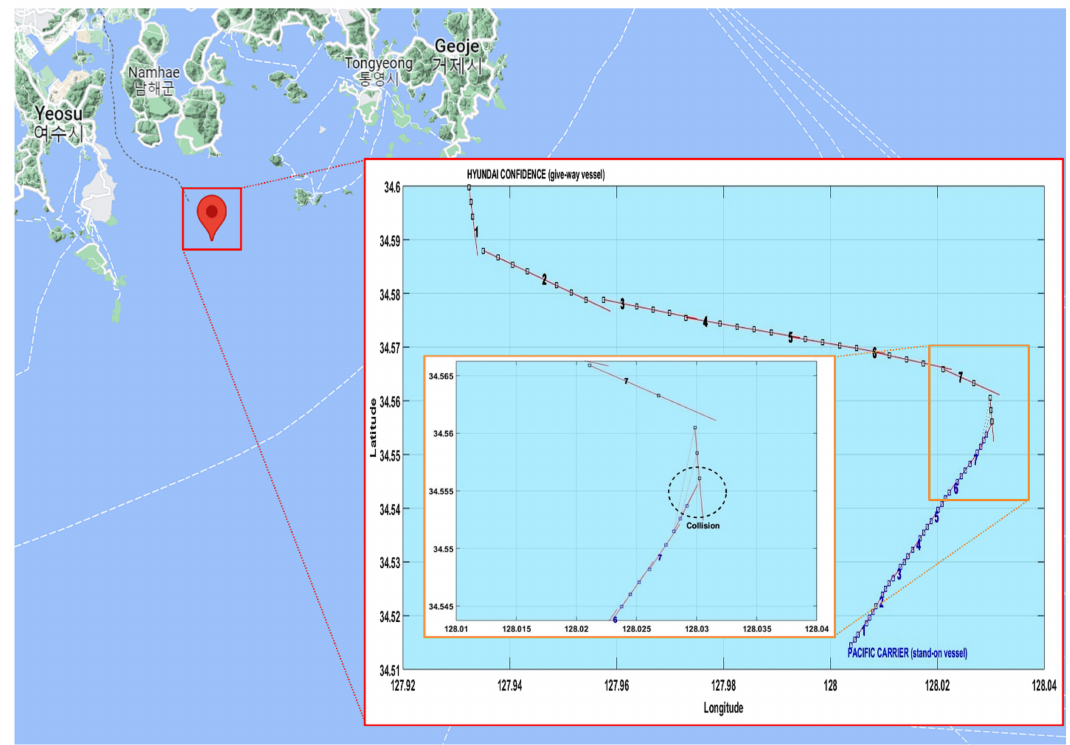
Figure 15. Ship trajectories of the collision accident between HYUNDAI CONFIDENCE and PACIFIC CARRIER.